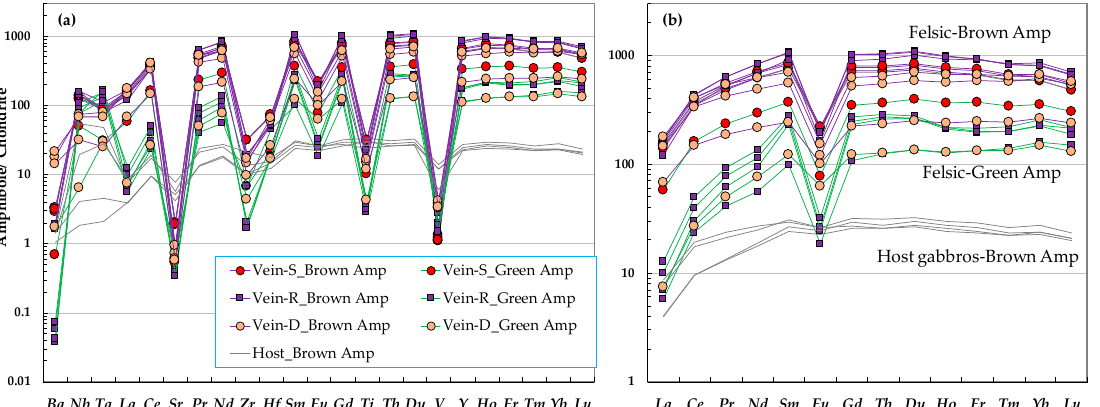
Figure 16. Chondrite-normalized trace ( a ) and REE ( b ) abundances of amphiboles in the host gabbros and felsic veins—Hole U1473A.